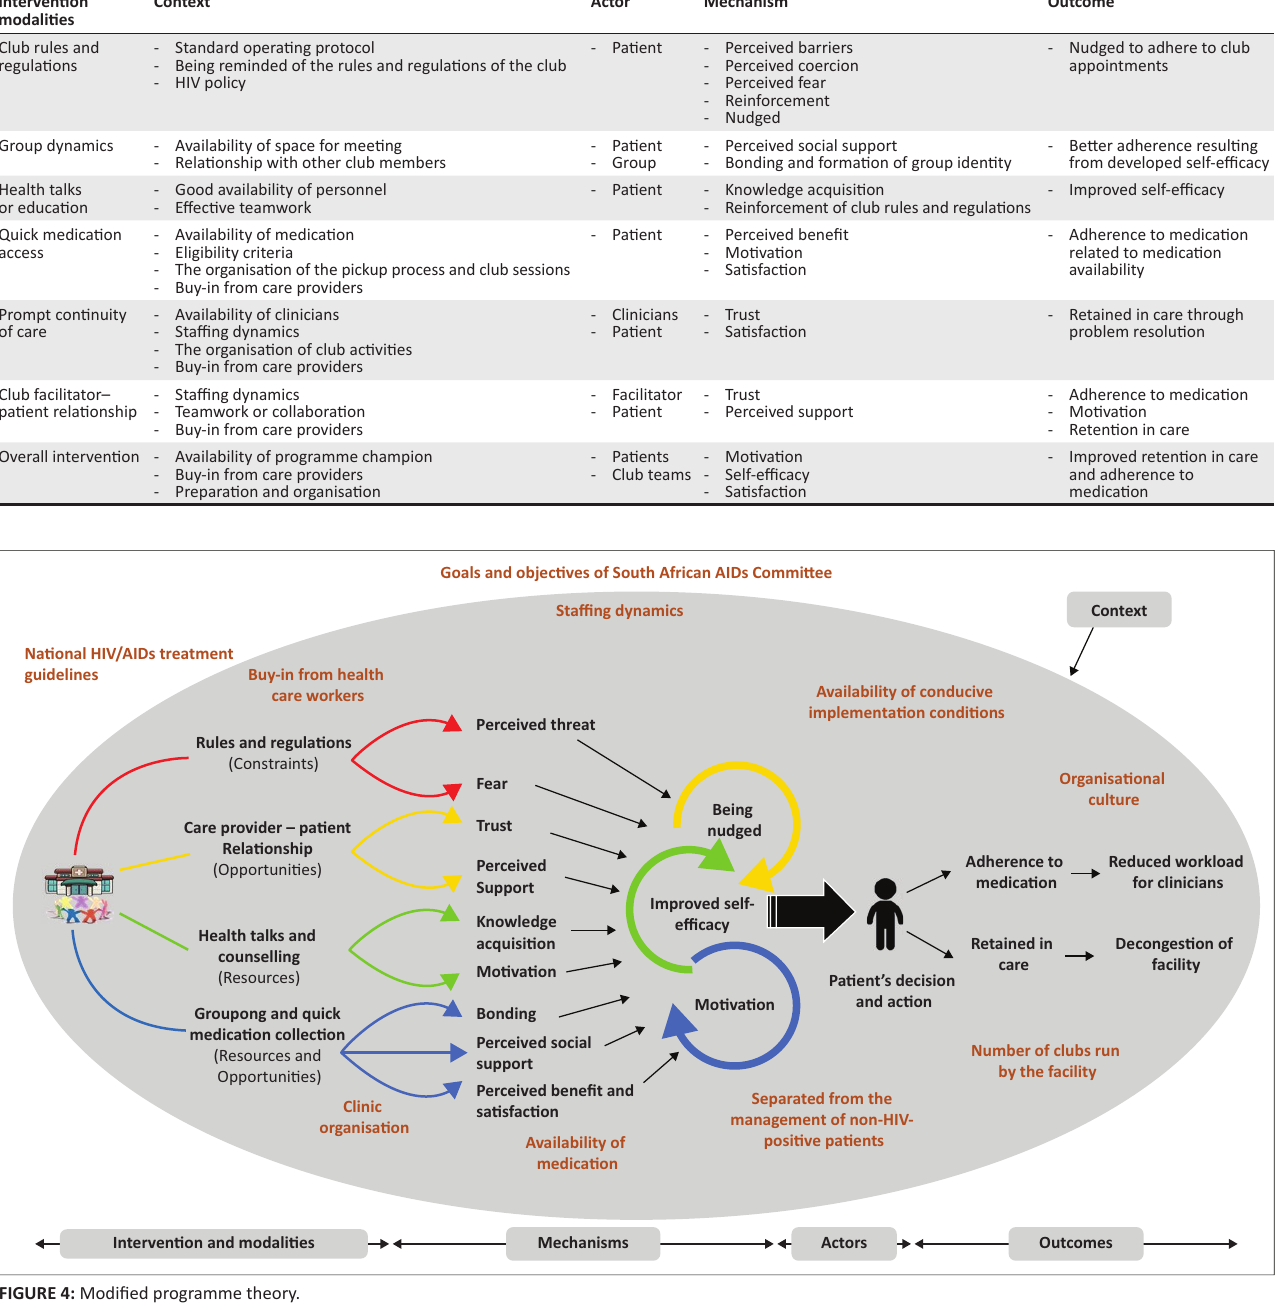
TABLE 6: Intervention–context–actor–mechanism–outcome matrix formulated from the study findings. Intervention